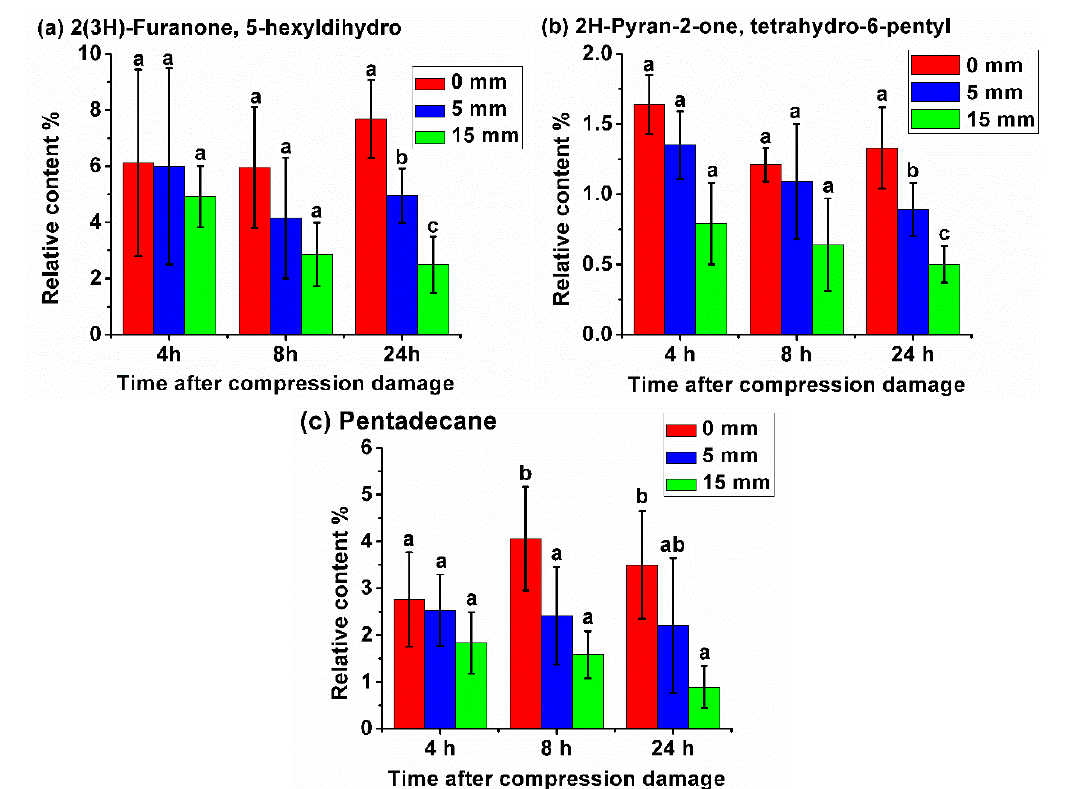
Figure 2. ( a – c ) Relative content of three volatile substances (VOCs) decreased with the increase of the level of compression damage.